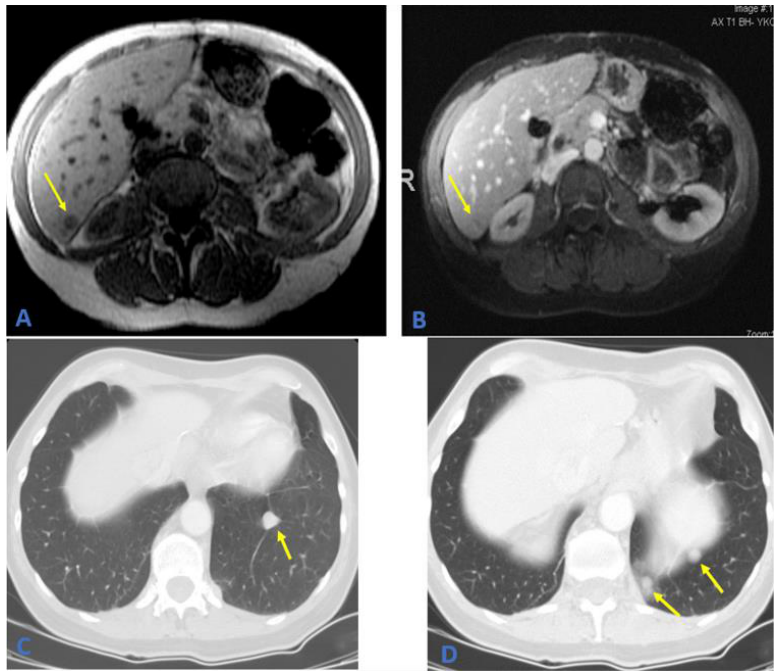
Figure 4. ( A , B ) MRI of the abdomen; T1 weighted images on the left showing hypointense hepatic focal lesion in segment 6 which is faintly enhanced on the post-contrast image on the right. ( C , D ) Axial CT scan of the chest showing multiple left lower lobe metastatic pulmonary nodules